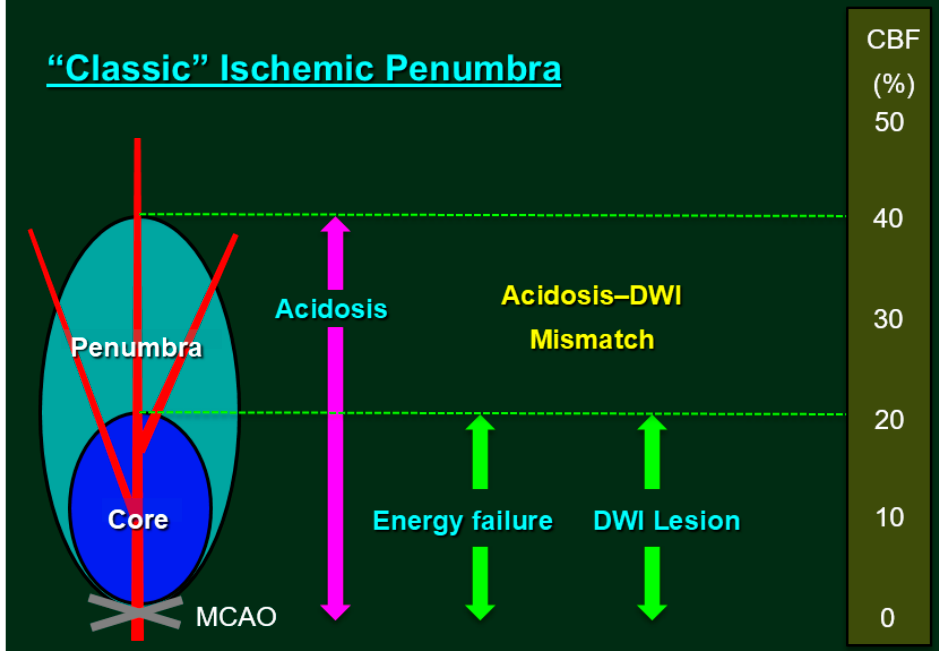
Figure 1. Classic Ischemic Penumbra. The ischemic penumbra is classically defined as an ischemic brain region with cerebral blood flow (CBF) between the upper threshold of electrical silence and the lower threshold of energy and ion pump failure [11,12]; the green dashed lines indicate the upper and the lower thresholds. Regions exhibiting CBF in the ischemic core range (CBF <20% of control values) had a 96% probability of undergoing infarction, while zones with higher CBF (>40% of control) were largely spared from infarction [13]. Under experimental conditions, the most reliable method for localizing the ischemic core involves inducing a loss of adenosine triphosphate (ATP), although tissue acidosis can be used as a biochemical marker of the ischemic core plus the penumbra [14]. Research has demonstrated that pH-weighted magnetic resonance imaging and diffusion-weighted imaging (DWI) mismatch (i.e., cytotoxic edema due to ATP depletion) can provide a more comprehensive zone of penumbra [15]. In routine clinical settings, however, lesions detected via early DWI can be